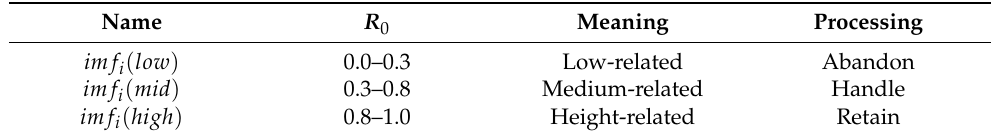
Table 2. Correlation coefficient